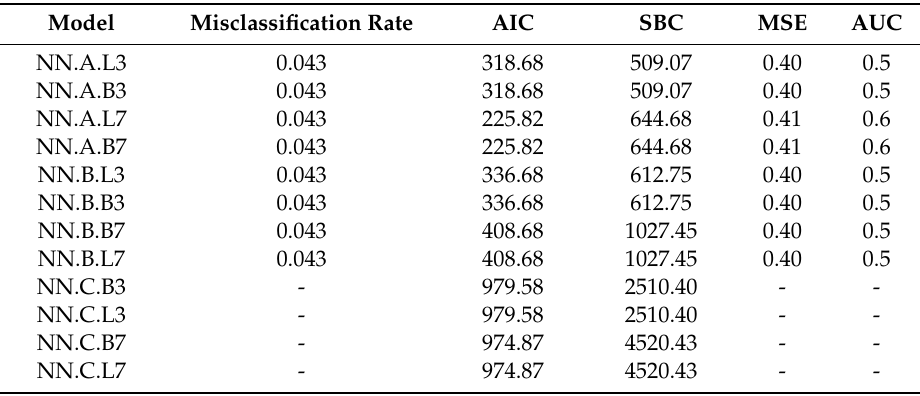
Figure 1. Box plot of the mean square error in neural network models. Table 13. Initial comparison of neural network